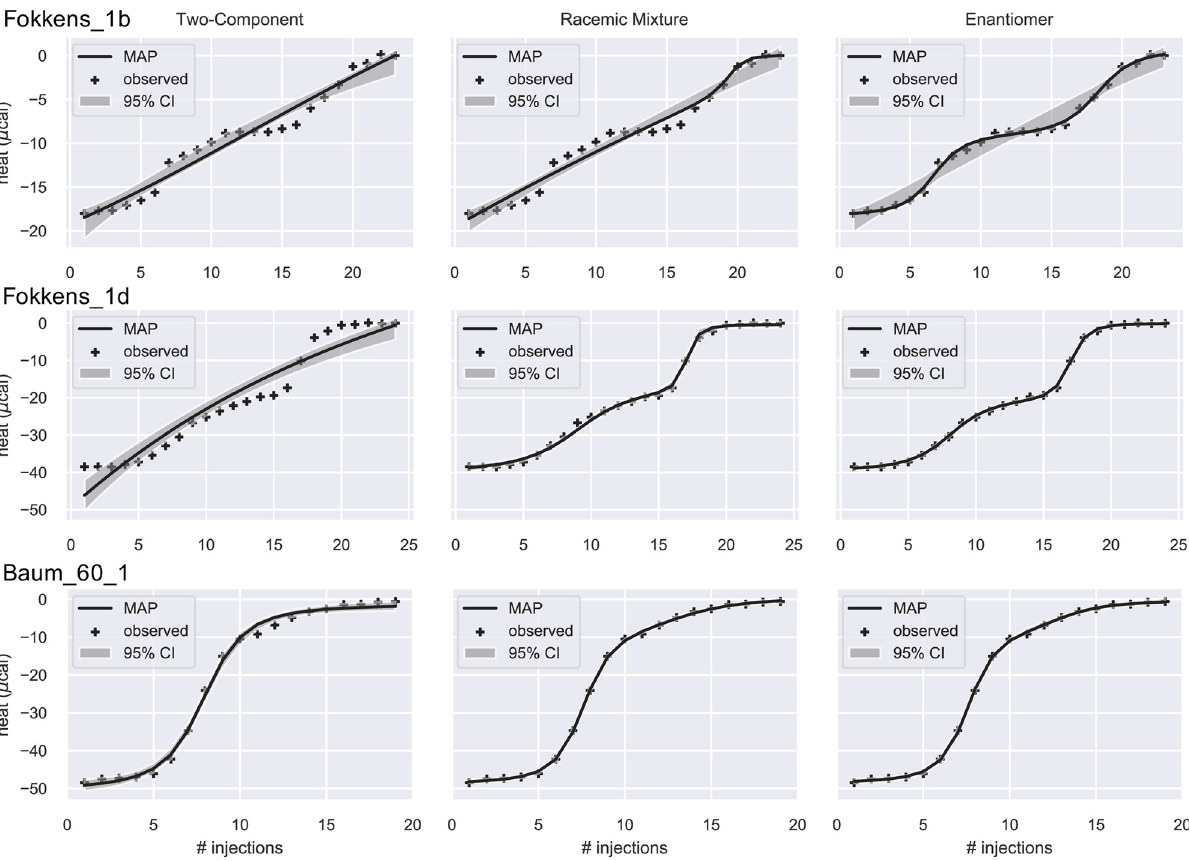
Fig 7. Integrated ITC heat data and their fit. The data were fitted by the 2C (left), RM (middle), and EM (right) models. The solid line is the theoretical heat q � ð θ Þ , where θ MAP is the Maximum a Posteriori estimate of the parameters. The grey band is the 95% confidence interval. Crosses MAP n are the observed heat. The three datasets are best fitted by both RM and EM models according to the estimated Bayes factors (Table 3).